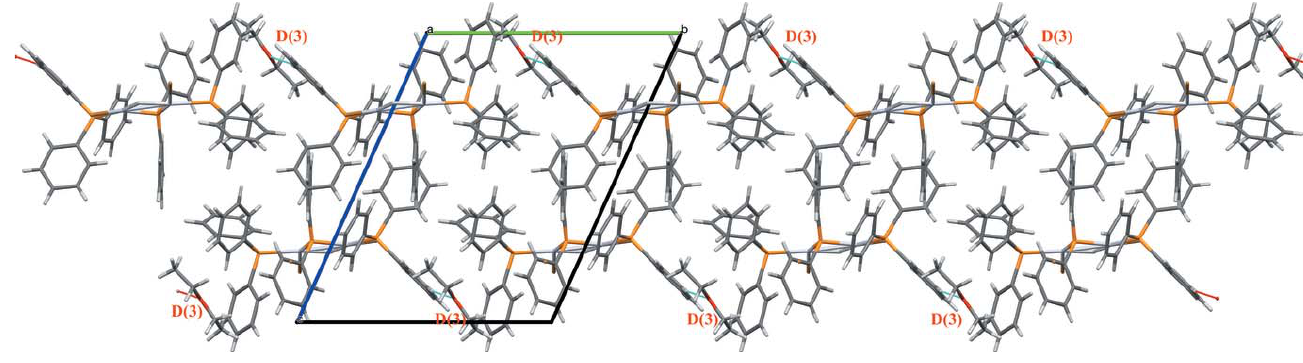
Figure 3 Partial packing diagram of the molecules along the b -axis direction, showing the C—H (cid:2)(cid:2)(cid:2) O hydrogen bonds (Table 2).